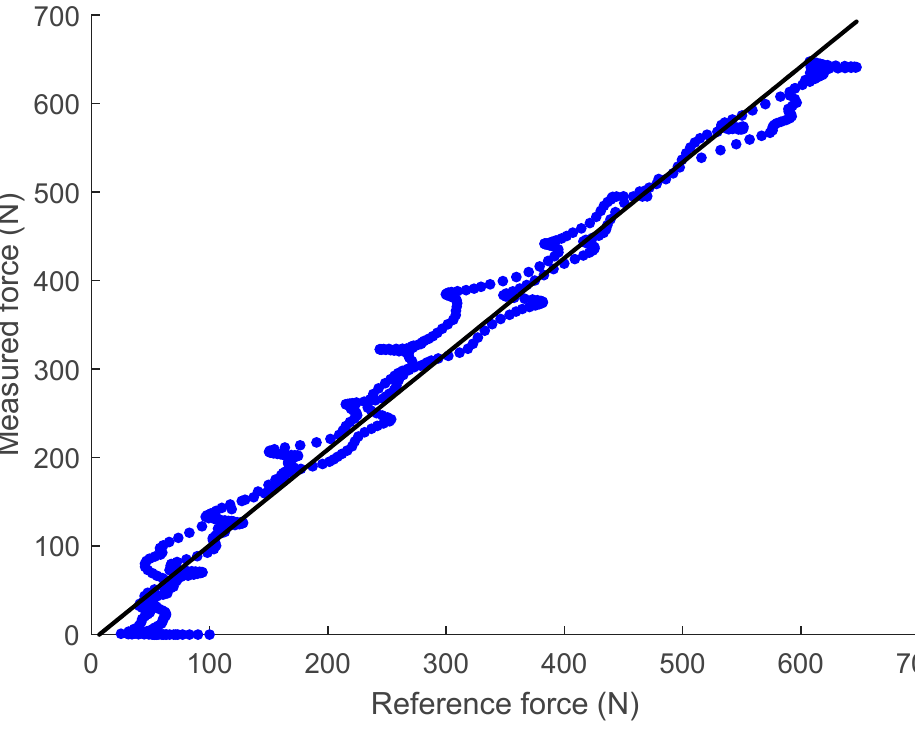
Figure 15. Linear regression of the unfiltered data taken from the FM-PLS sensor and reference off-the-shelf loadcell.